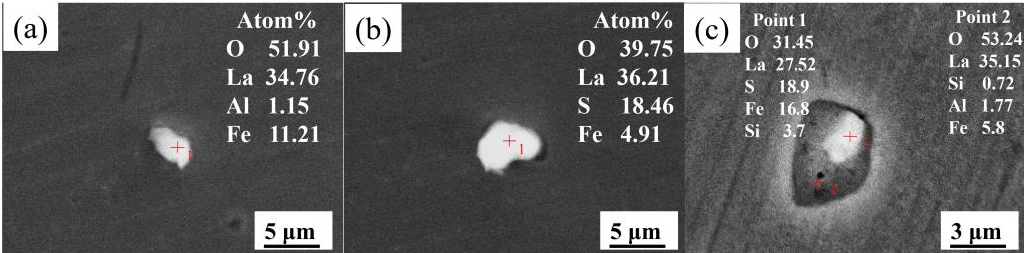
Figure 4. SEM images and EDS results of typical inclusions in steel containing 0.0425 wt.% La: ( a ) La 2 O 3 , ( b ) La 2 O 2 S, and ( c ) La 2 O 2 S-La 2 O 3 complex inclusion.